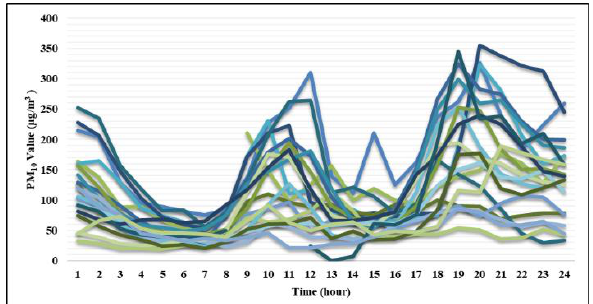
Figure 6. PM 10 values of Zonguldak at 2014 winter period.